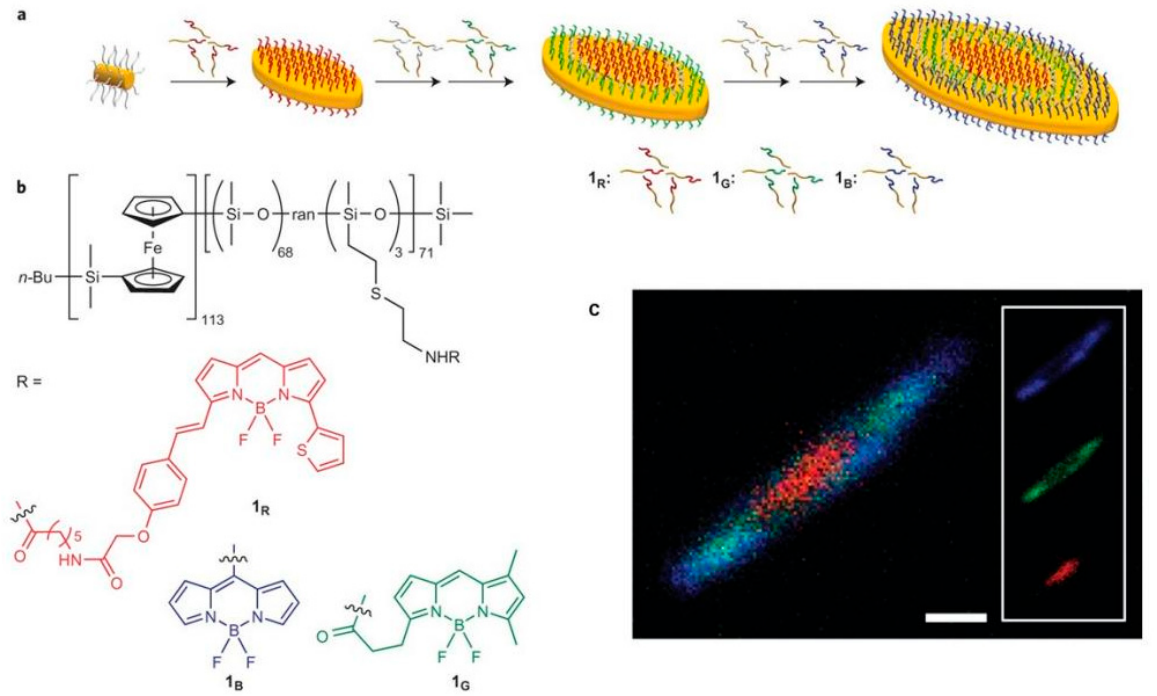
Figure 7. ( a ) Schematic diagram of block co-micelles. ( b ) Chemical structures of functional